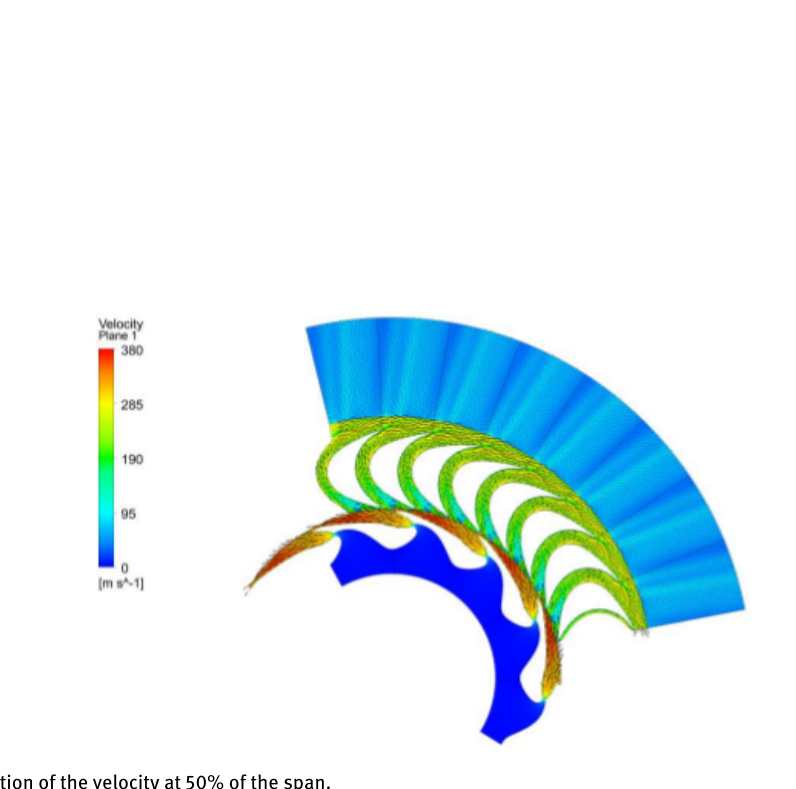
Figure 4: The blading of the centrifugal stage.